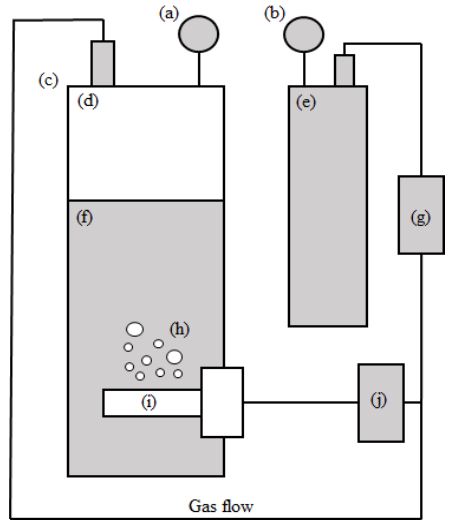
Figure 1. Schematic view of a nanobubble Generator [16]. ( a ) Pressure gauge (air pressure in water tank), ( b ) pressure gauge (air pressure in air tank), ( c ) water tank, ( d ) air, ( e ) gas tank, ( f ) water, ( g ) pressure gauge (outflow), ( h ) bubble, ( i ) filter, and ( j ) pressure gauge (inflow).